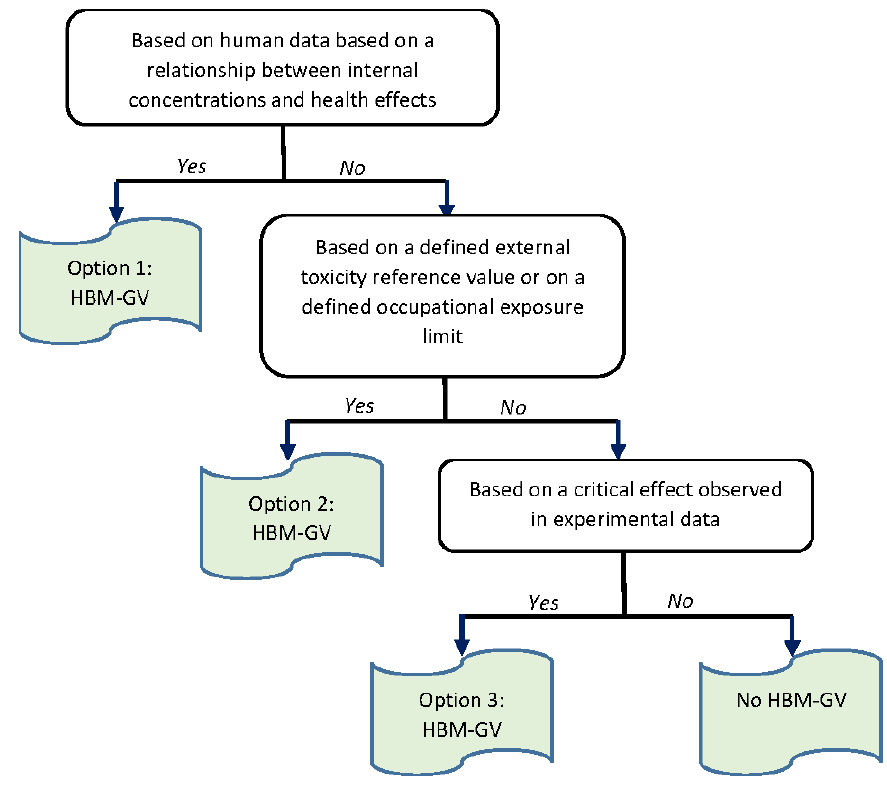
Figure 1. General methodology used to derive HBM-GVs as presented in Apel et al., 2020 [29].